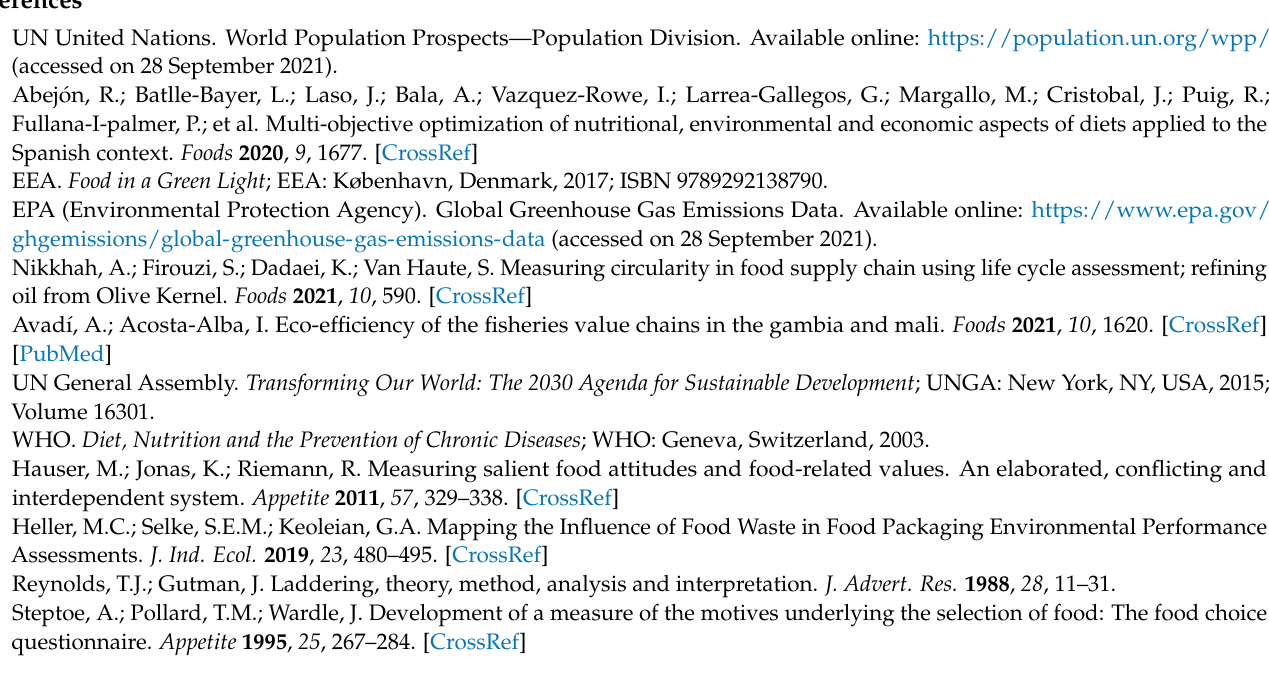
and Carbon-Footprint/Energy index (CFE index) of the food items, Table S2: Total amount of ingredi- ents (divided by course and category) used in the menus, Table S3: Recipes from the school canteen meals, Figure S1: Carbon-Footprint/Food Energy (CFE) index graph for the analysed